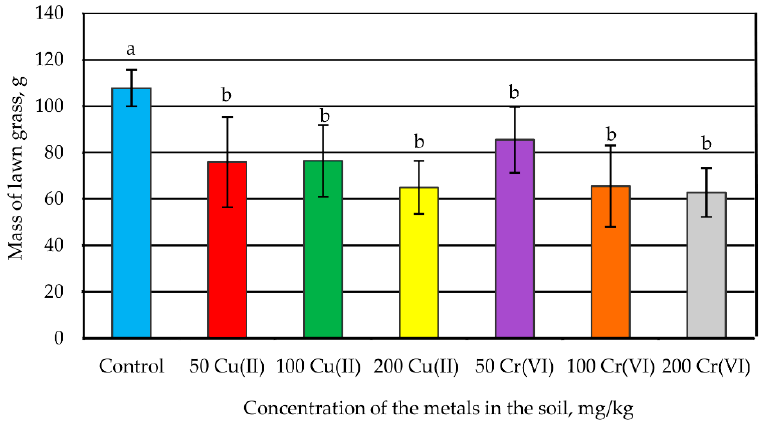
Figure 4. The influence of the metals on the dry mater yield of grass ( х ± SD, n = 5) with different letters significantly differ from each other based on Bonferroni correction at p < 0.05.